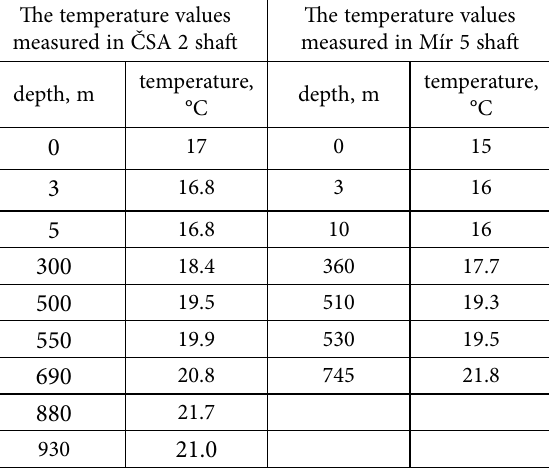
Table 2. The temperature and the depth of the temperature